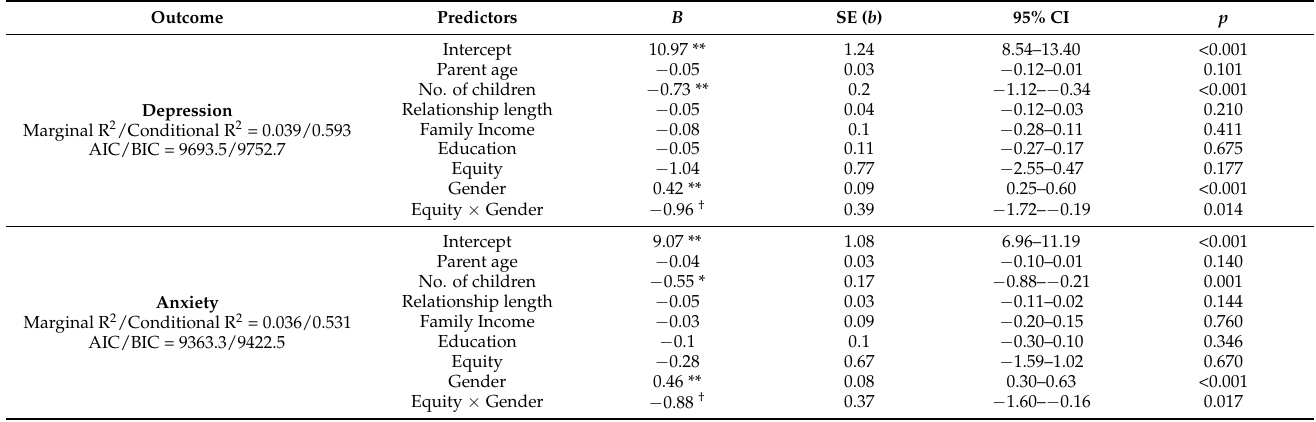
Table 6. Effects of equity on Male vs. Female parents’ well-being in mixed-sex couples. Outcome